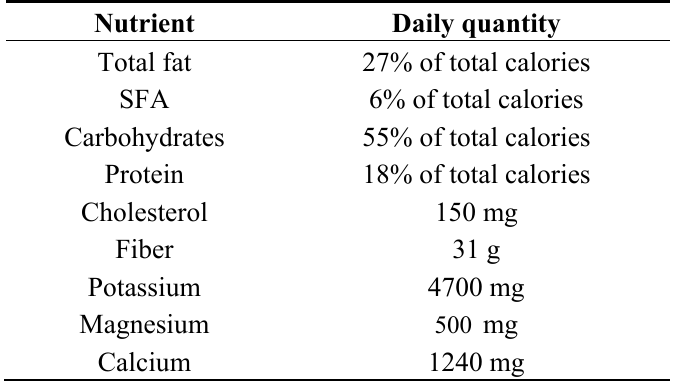
Table 3. Dietary Approach to Stop Hypertension (DASH) diet composition